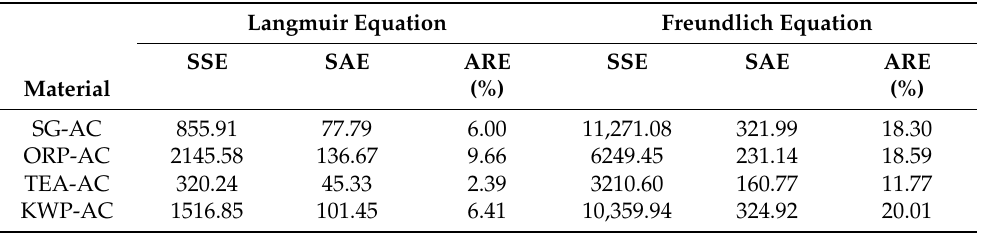
Figure 11. Dependence of the PRM adsorption capacity on the specific surface area. Table 4. The values of three different error analyses of isotherm models for adsorption of PRM onto AC